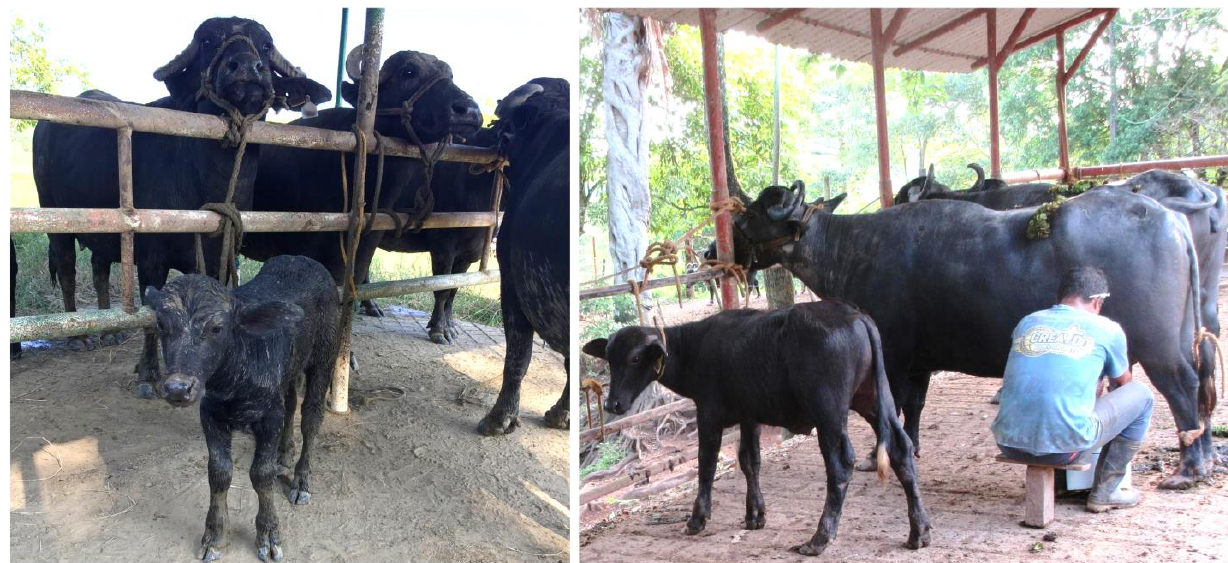
Figure 4. Presence of the calf during milking, a factor identified as a positive visual, tactile, and auditory stimulus for adequate milk ejection in buffalo cows ( Bubalus bubalis